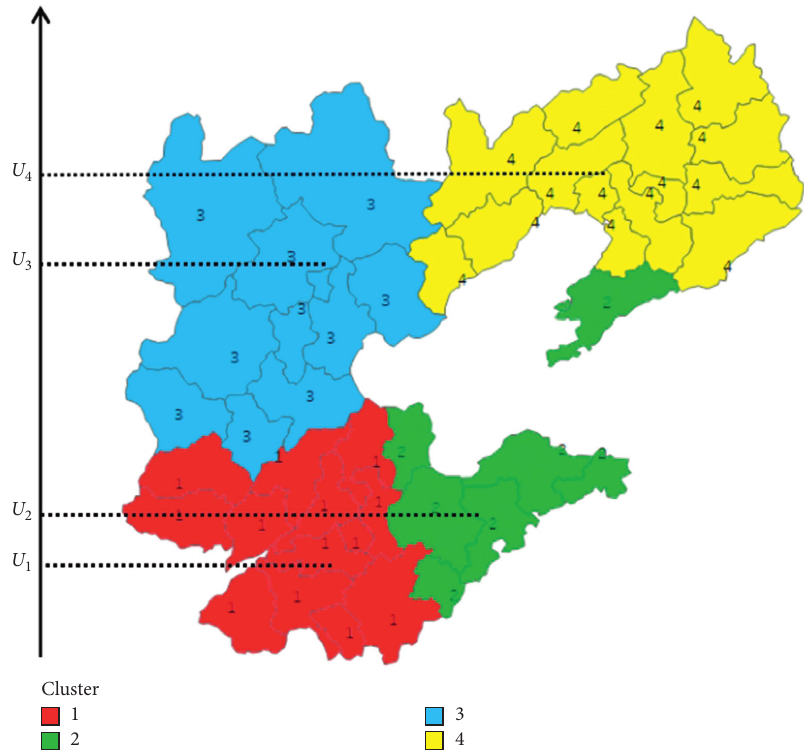
Figure 4: Four clusters obtained by M -motif spectral clustering algorithm. Tableau Public 10.4 was used to create the map. 8